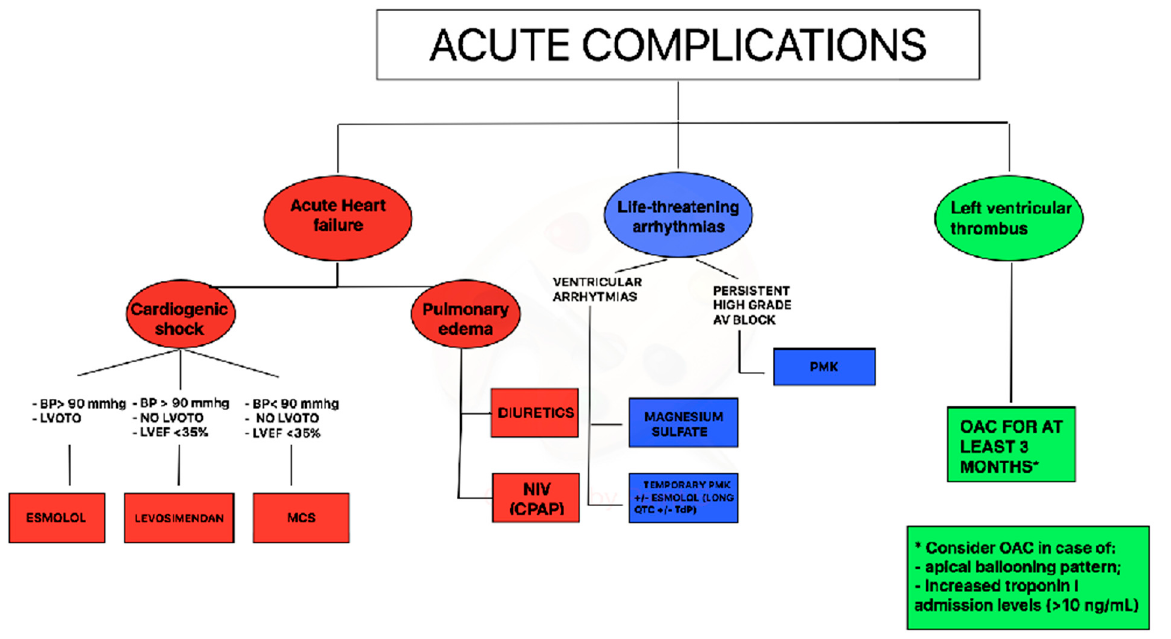
Figure 1. Proposal of acute complications management during Takotsubo syndrome (TTS) syndrome. Legend: AV = atrioventricular, BP = blood pressure, CPAP = Continuous positive airway pressure, LVOTO = left ventricular outflow tract obstruction, LVEF = left ventricular ejection fraction, MCS = mechanical circulatory support, NIV = non-invasive ventilation OAC = oral anticoagulation, PMK = pacemaker.